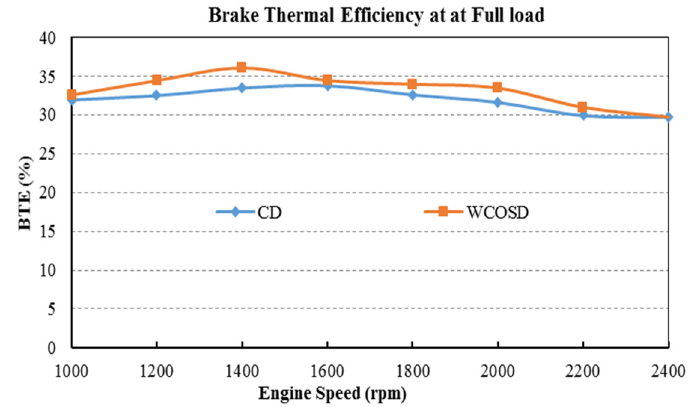
Figure 2. The brake thermal efficiency at full load condition. Figure 3. The brake thermal e ffi ciency at full load condition. Figure 3. The BSFC at full load condition.